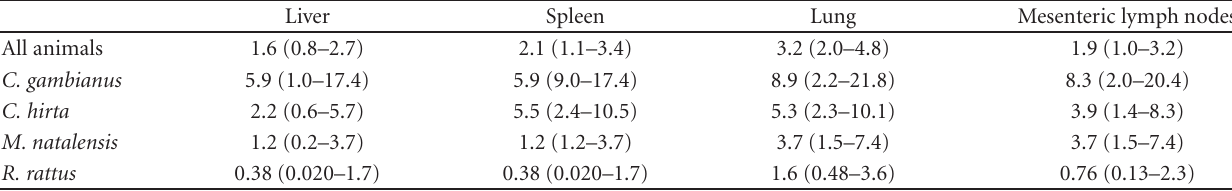
Table 4: Positivity of mycobacteria (in %) in di ff erent organs for all animals and for the main animal species collected. Liver Spleen Lung All animals